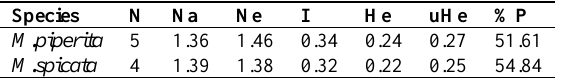
Table 3. Genetic diversity parameters determined in